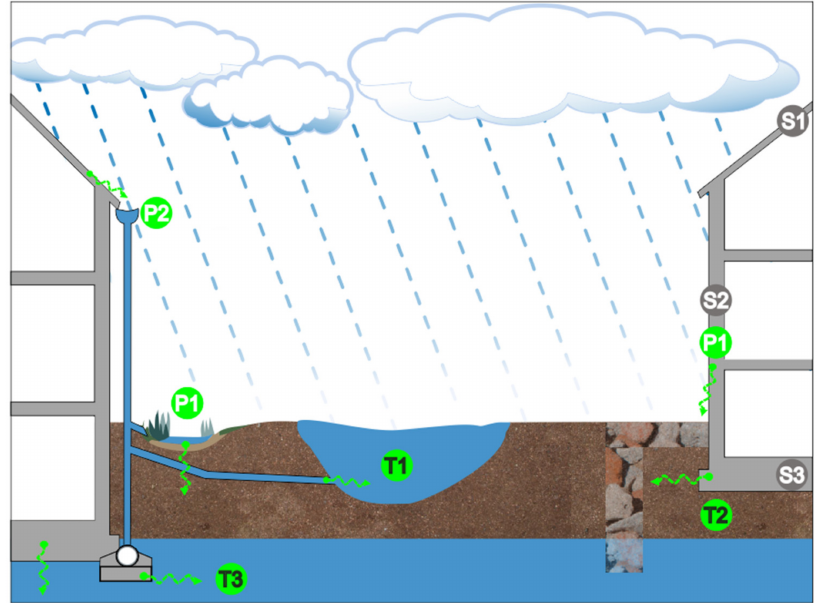
Figure 4. Visualization of parts of the scenario for the release of substances from construction products of the building envelopes to the environment. Possible sources are roofs (S1), facades (S2) and foundation (S3), paths are runoff (P1) and infiltration (P2), and targets can be water bodies (T1), soil (T2) and groundwater